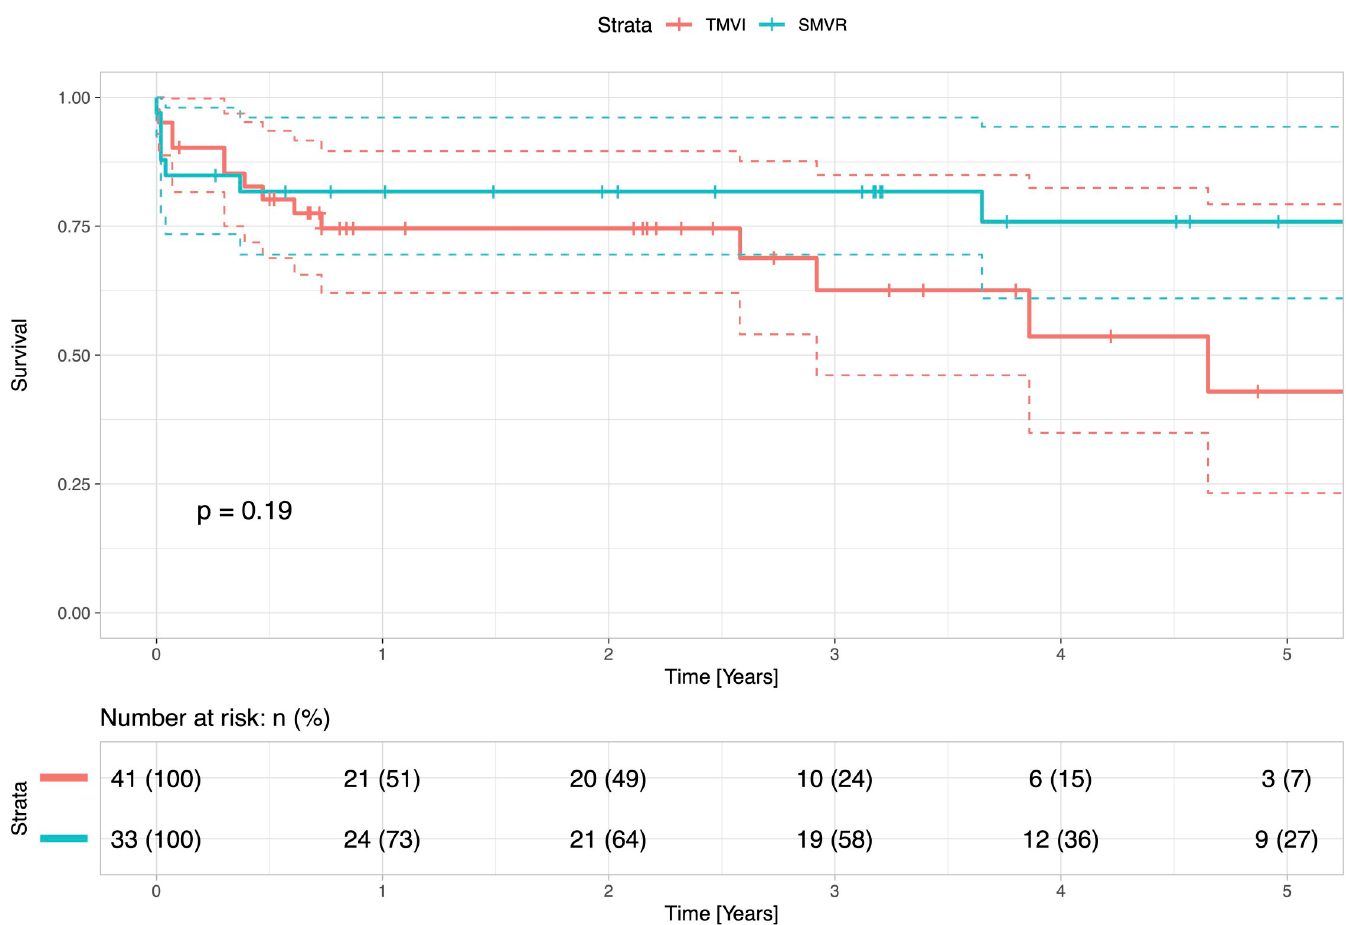
Fig 2. Survival of patients undergoing redo SMVR and TA-TMVR. The figure presents the survivals of patients undergoing a redo SMVR and TA-TMVR presented with Kaplan-Meier curves. The survival rates have been analysed and compared with the log rank test and show no statistical difference (p > 0.05).